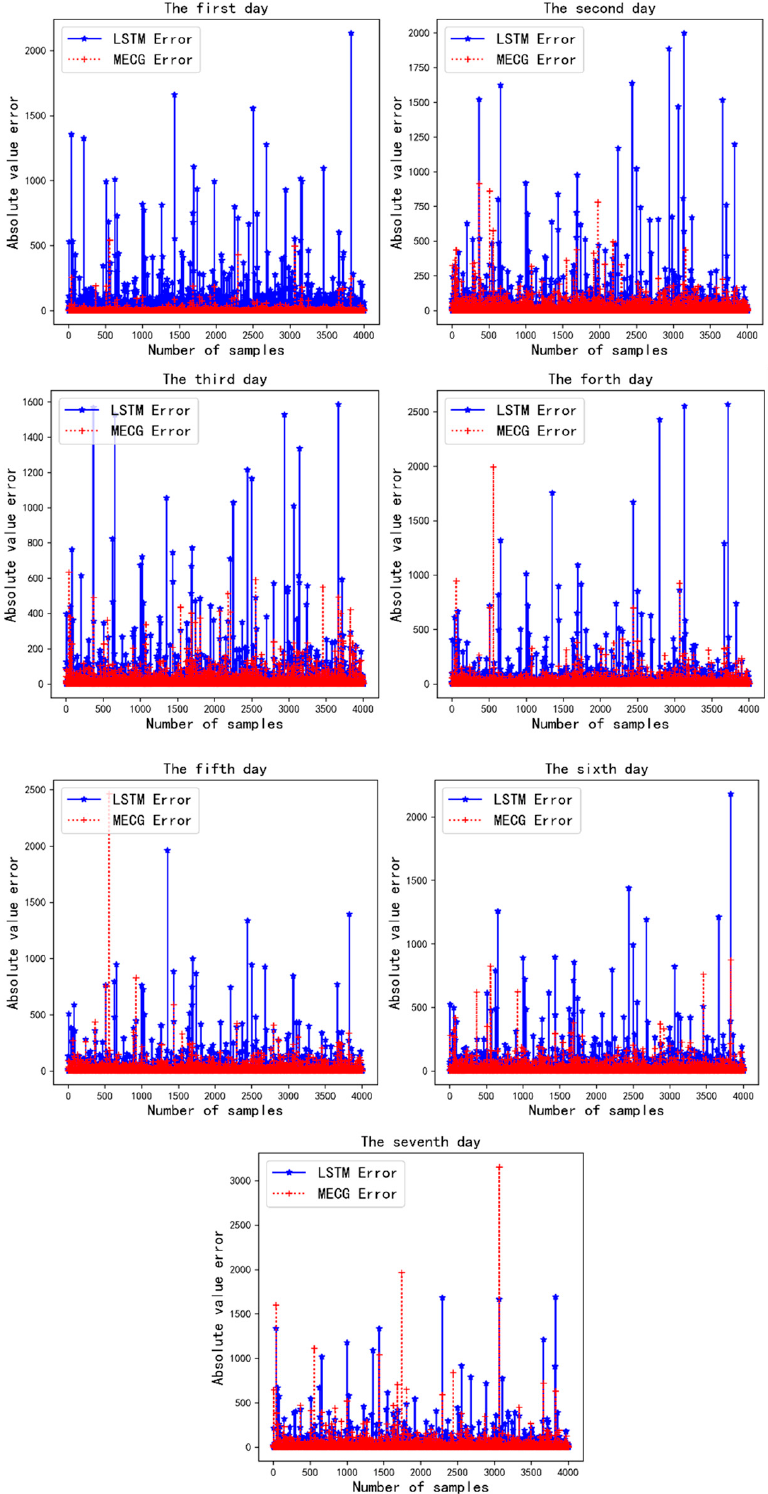
Figure 16. Absolute error values of LSTM and MECG models for all samples.